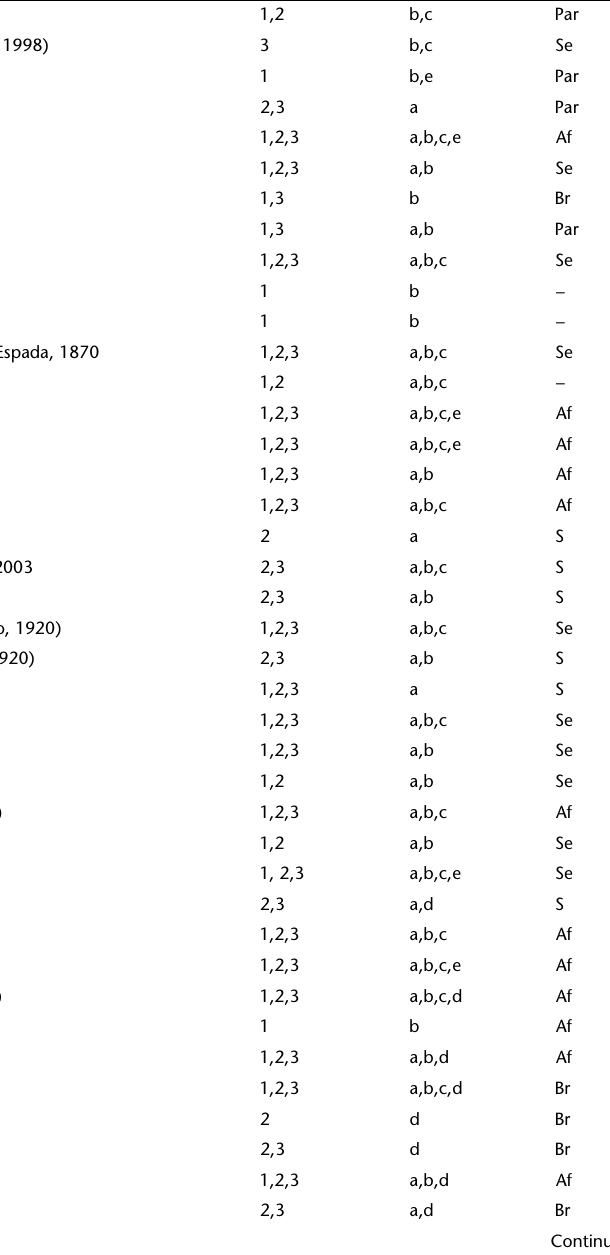
Table I. Species composition of anurans from Parque Municipal Nascentes de Paranapicaba (PNMNP), Santo André, São Paulo. Type of data collected: 1. Primary data from field surveys during the study period; 2. secondary data gathered from herpetological collection catalogs, 3. secondary data from Verdade et al. (2009). Localities of occurrence at site areas: a. Paranapiacaba or Alto da Serra, b. PNMNP (study area), c: Reserva Biológica do Alto da Serra de Paranapicaba, d: Campo Grande da Serra, e: Santo André municipality. Geographical distribution: Par: species exclusive to Paranapiacaba region, S: endemic for the Serra do Mar from São Paulo state, Se: Serra do Mar formation, south and southeastern Brazil, Af: broad distribution within the Atlantic forest, Br: broad distribution in Brazil. * Represents “Paranapiacaba” or “Alto da Serra” as type locality; ** Paranapiacaba as type locality of one of the species synonyms; ***Campo Grande as type locality.